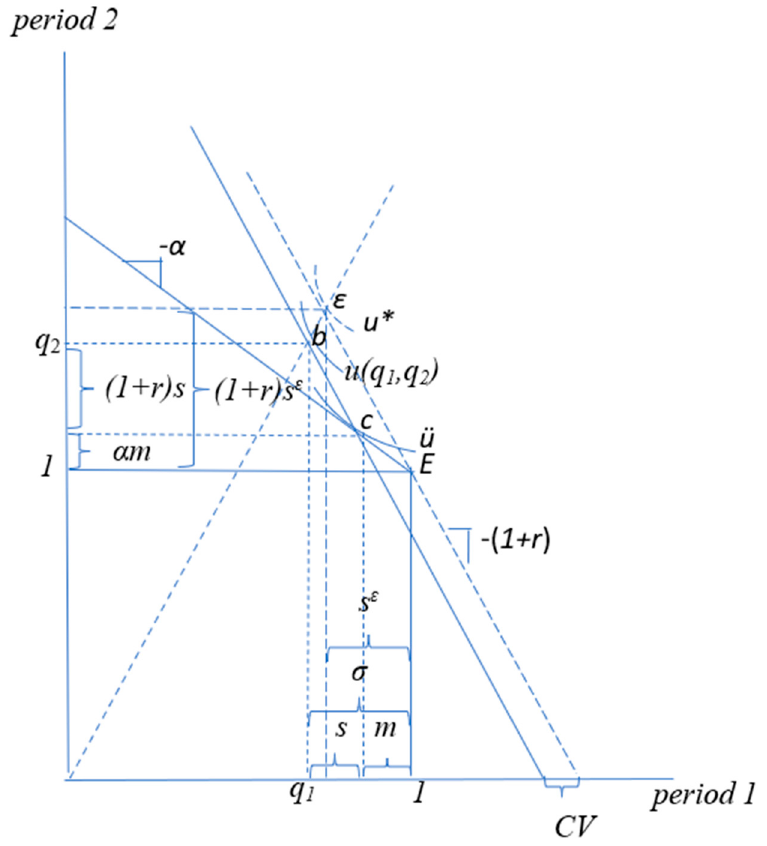
Figure 1. Money as insurance against uncertainty.